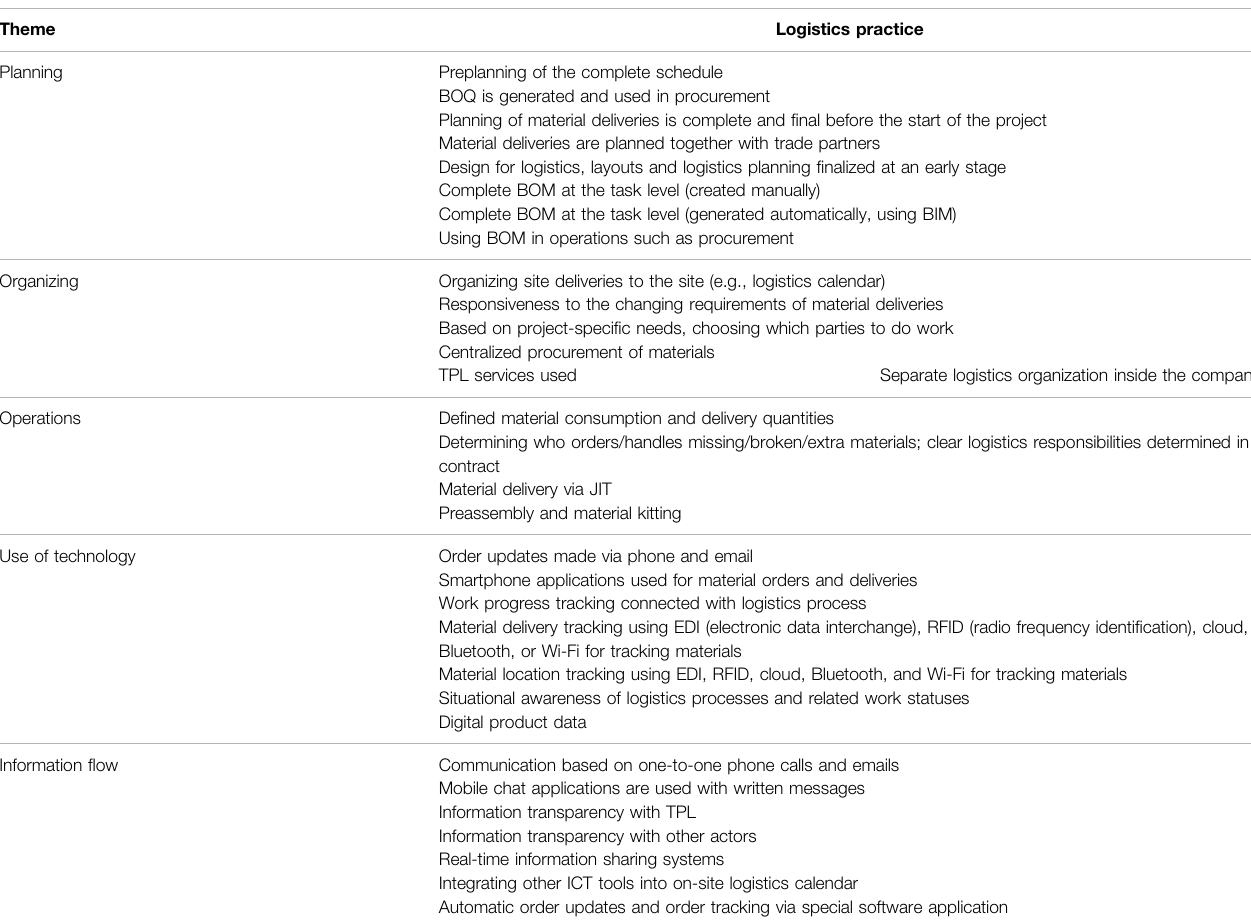
TABLE 4 | Logistics practice elements (listed from low to high in terms of maturity within the